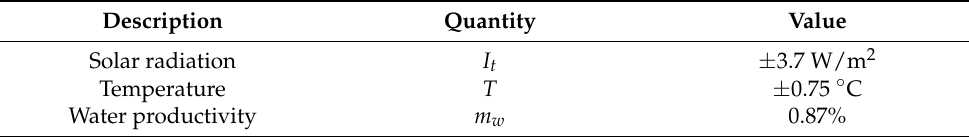
Table 1. Measured variable